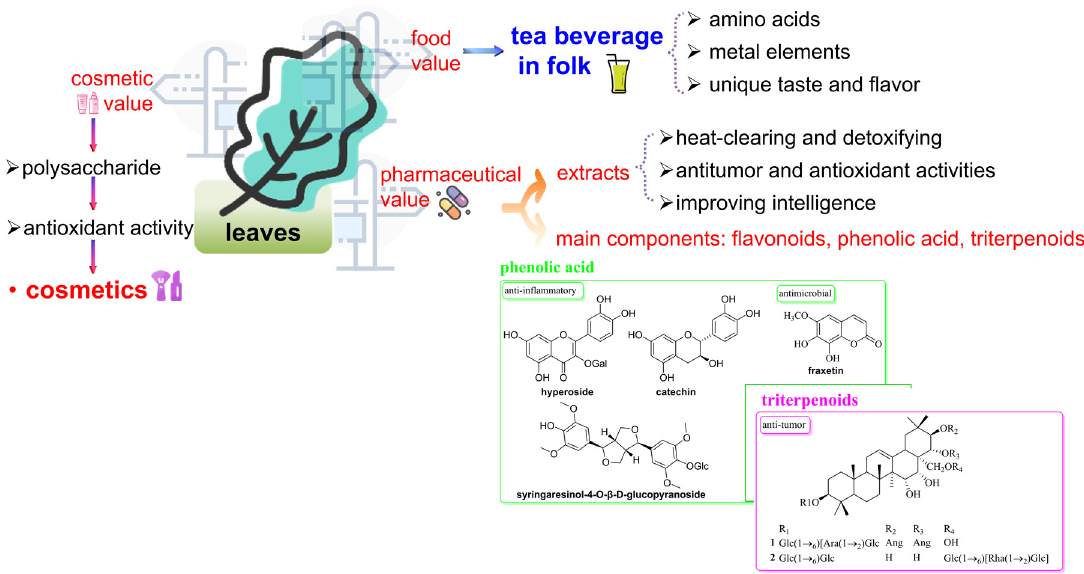
Figure 5. The uses of leaves of X.